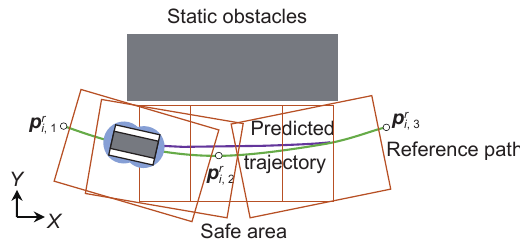
Fig. 2 Safety zones for robots in static